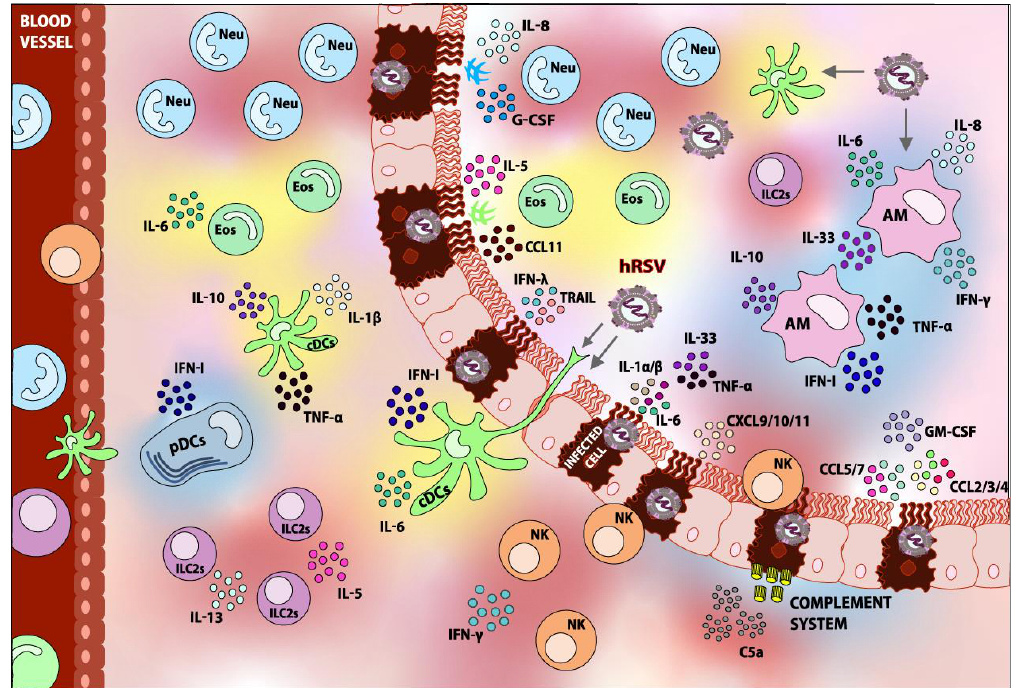
Figure 1. Innate immune response elicited upon hRSV infection. Following the detection of hRSV, various types of immune cells are recruited to the lung. Within the innate immune cells, Dendritic cells (DCs), Alveolar Macrophages (AMs), Neutrophils (Neu), Eosinophils (Eos), Natural Killer cells (NK), and Group 2 Innate Lymphoid Cells (ILC2s) can be found. Accordingly, the fixation and activation of the Complement System is detected. Most of these components play a role in the pathology of the infection. The role of the respiratory epithelium in the recruitment of innate immune cells can also be appreciated. Components shaded in blue are elements that contribute to hRSV disease-resolving, whereas components shaded in red are considered detrimental and contribute to hRSV pathogenesis overall. Elements depicted in yellow are those whose contributions to hRSV pathology are not well studied or are controversial. The arrows indicate the possible targets of infection.